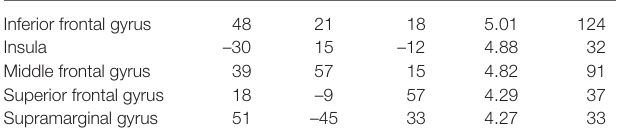
TABLE 2 | Regions showing significant positive and negative functional connectivity before and after treatment